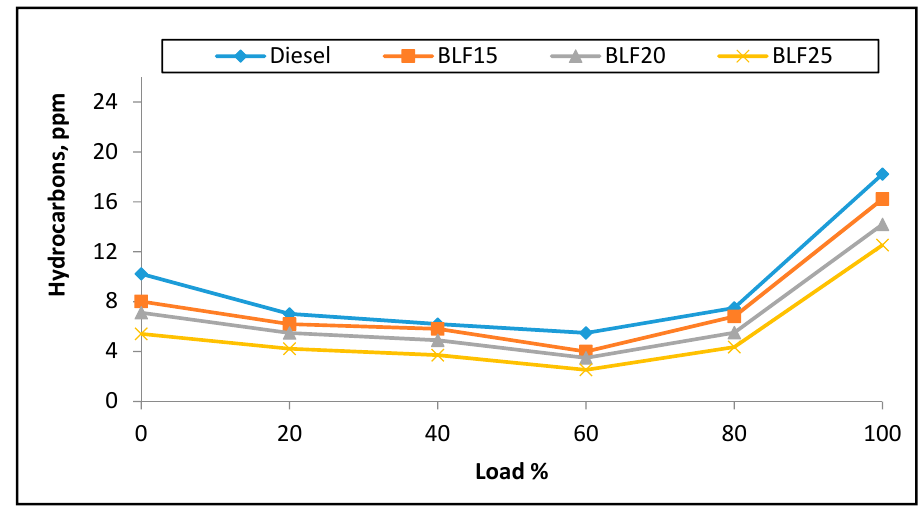
Figure 11. Variations of HC vs. engine load percent.